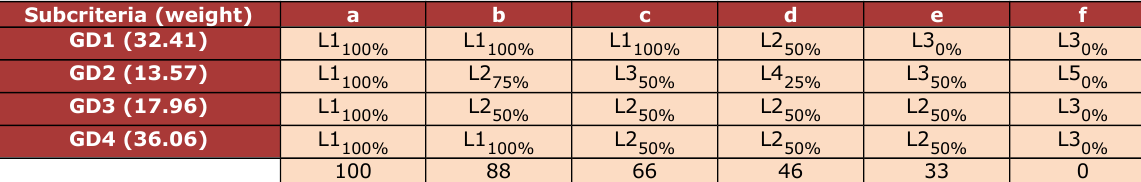
Table 2. Limits between state for green design